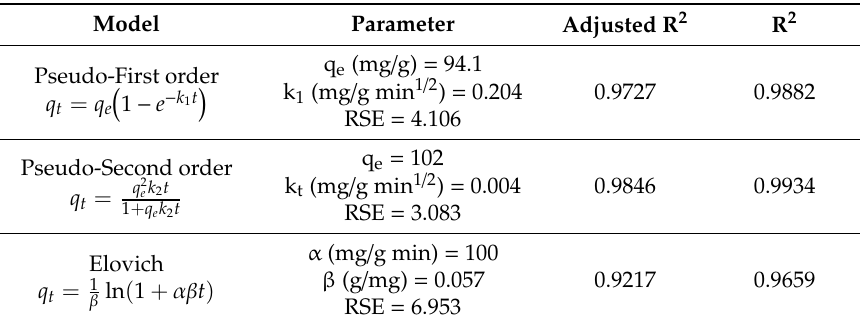
Table 4. Adjusted non-linear adsorption